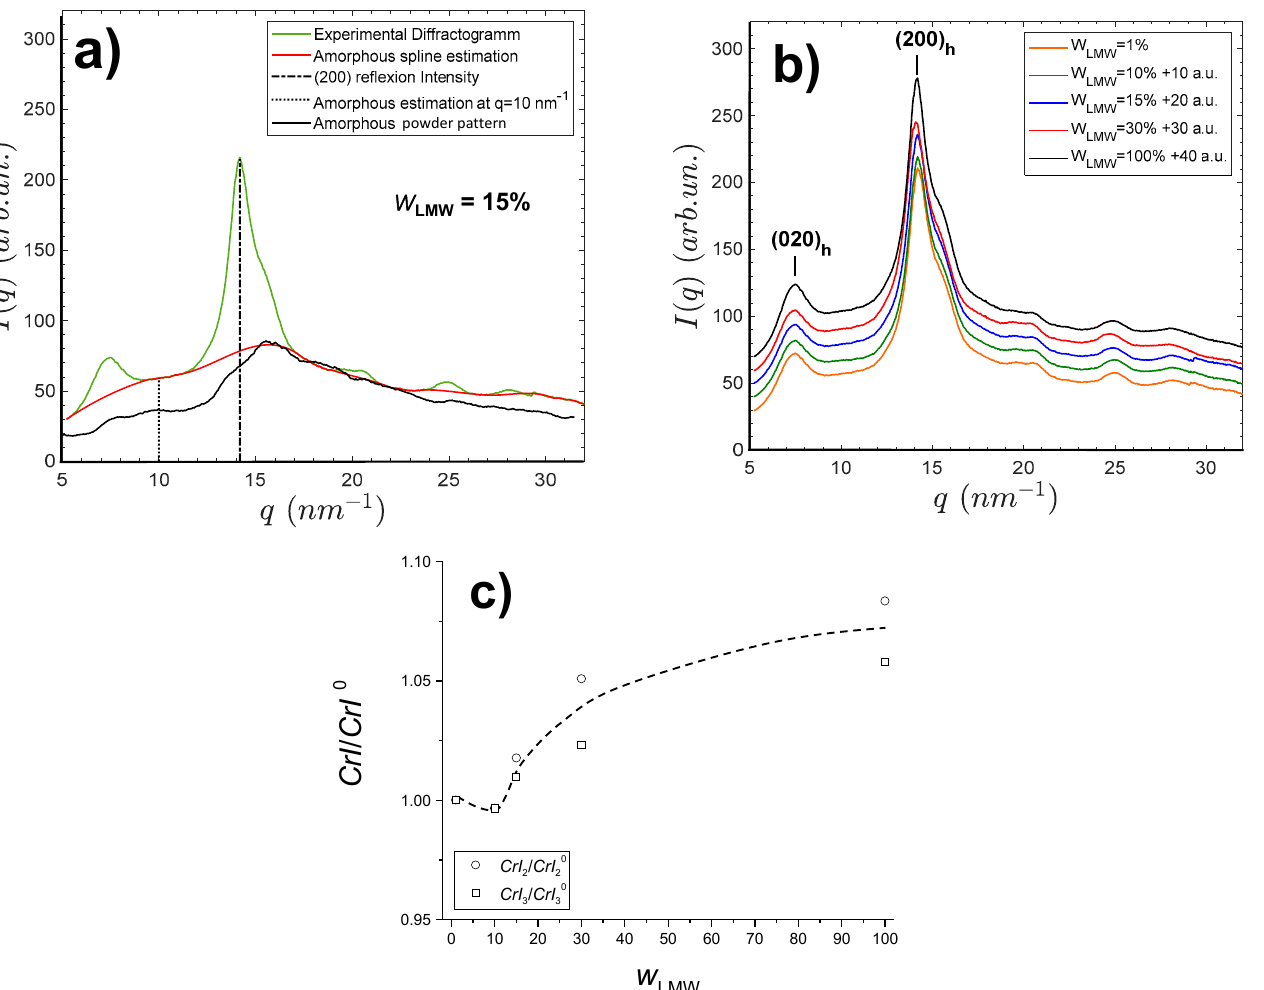
Figure 2. Wide angle synchrotron X-ray scattering patterns of films processed from mixed LMW and HMW chitosan aqueous solutions. ( a ) Procedures for the calculation of crystallinity index ( CrI ) applied to the 10% LMW chitosan-containing film diffractogram (green), by using the WAXS pattern of an experimentally obtained chitosan amorphous sample (black, CrI 3 ), by estimating the amorphous contribution by a cubic spline calculated from amorphous regions of the diffractogram (red, CrI 2 ), and by simply using the method by Focher et al. [58] relation with the intensity of the (200) h reflection and that at q ~10 nm − 1 (dot line, CrI 1 ). ( b ) WAXS patterns of films containing different LMW chitosan contents w LMW . Curves are shifted for clarity as indicated. ( c ) Normalized plots for the evolution of crystallinity indexes CrI 2 and CrI 3 with weight fraction of LMW chitosan. The normalization is performed with crystallinity indexes at 𝑤 𝐿𝑀𝑊 = 1%. Table 2. Crystallinity indexes 𝐶𝑟𝐼 (cid:2869) , 𝐶𝑟𝐼 (cid:2870) , and 𝐶𝑟𝐼 (cid:2871) obtained by different methods using X-ray diffraction patterns for chitosan films obtained with varied weight percentage of LMW chitosan 𝑤 (cid:3013)(cid:3014)(cid:3024) in the precursor solutions. 𝐶𝑟𝐼 (cid:2869) was obtained from Folcher et al. [58] 𝐶𝑟𝐼 (cid:2870) and 𝐶𝑟𝐼 (cid:2871) were obtained as previously reported by Osorio-Madrazo et al. [43].